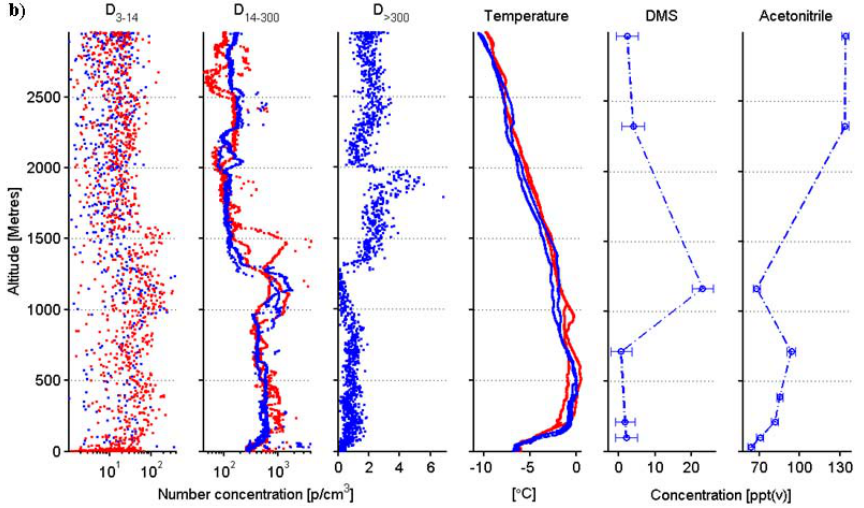
Fig. 9b. Vertical profiles of aerosol particle number concentration, temperature, and dimethyl sulphide (DMS) and acetonitrile concentrations (error bars give the 95% confidence interval) during ASCOS 2008 expedition helicopter flights, Period 2: 23:17–23:57UTC, 21 August (DoY 234) 2008 (red); 07:26–08:03UTC, 22 August (DoY 235) 2008